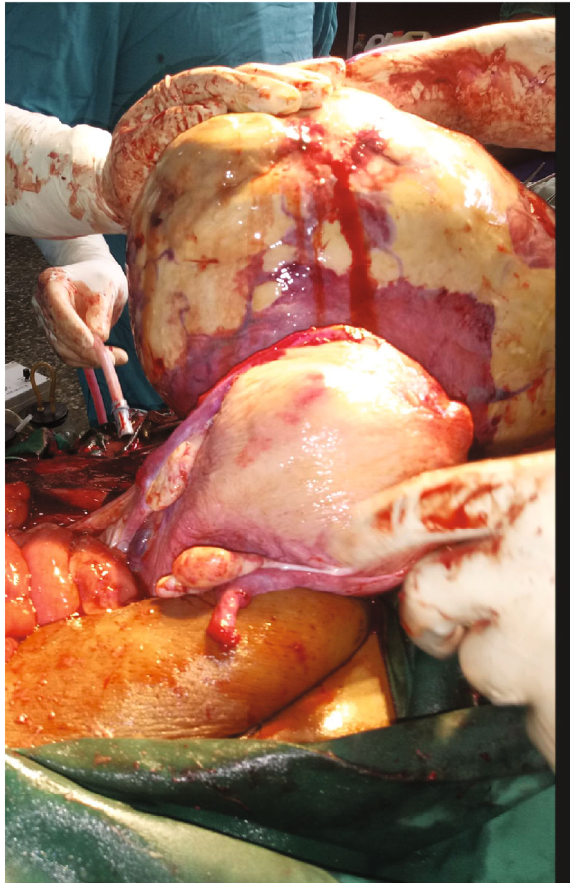
Figure 2: Relationship of the fi broid to the uterus.